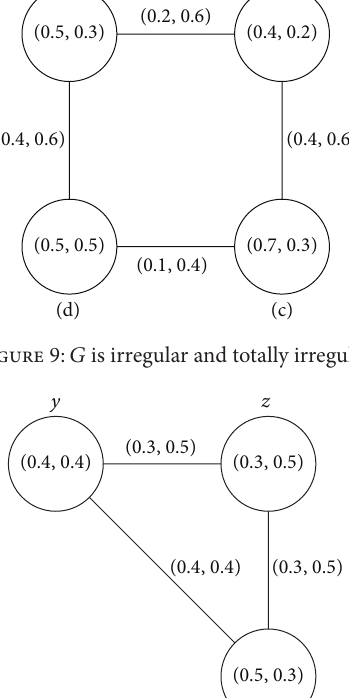
Figure 8: 𝐺 is irregular.